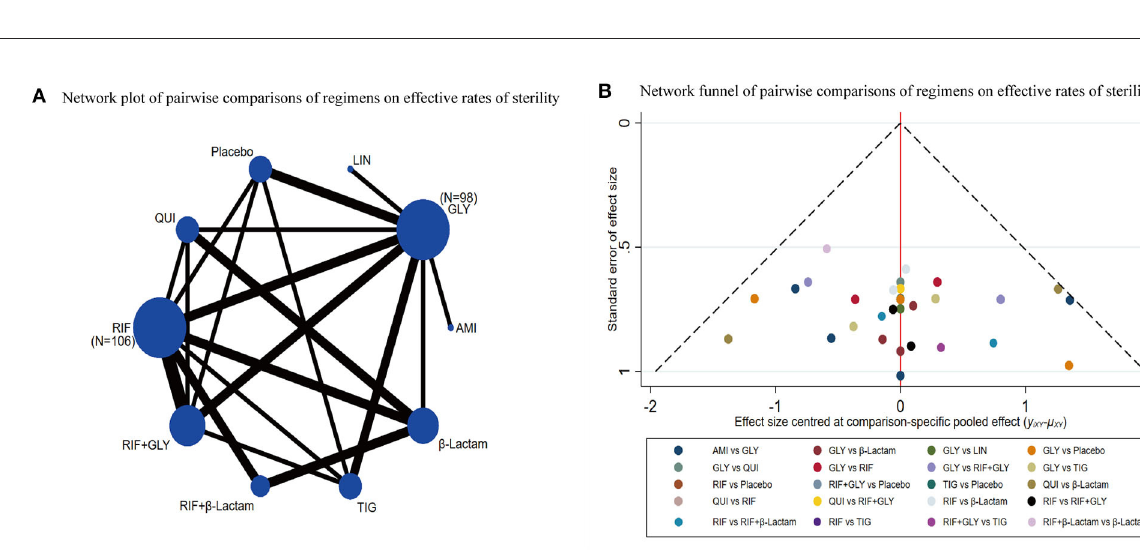
FIGURE3 Network meta-analysis of the total effective rates of sterility (A) network graph; (B) the network funnel